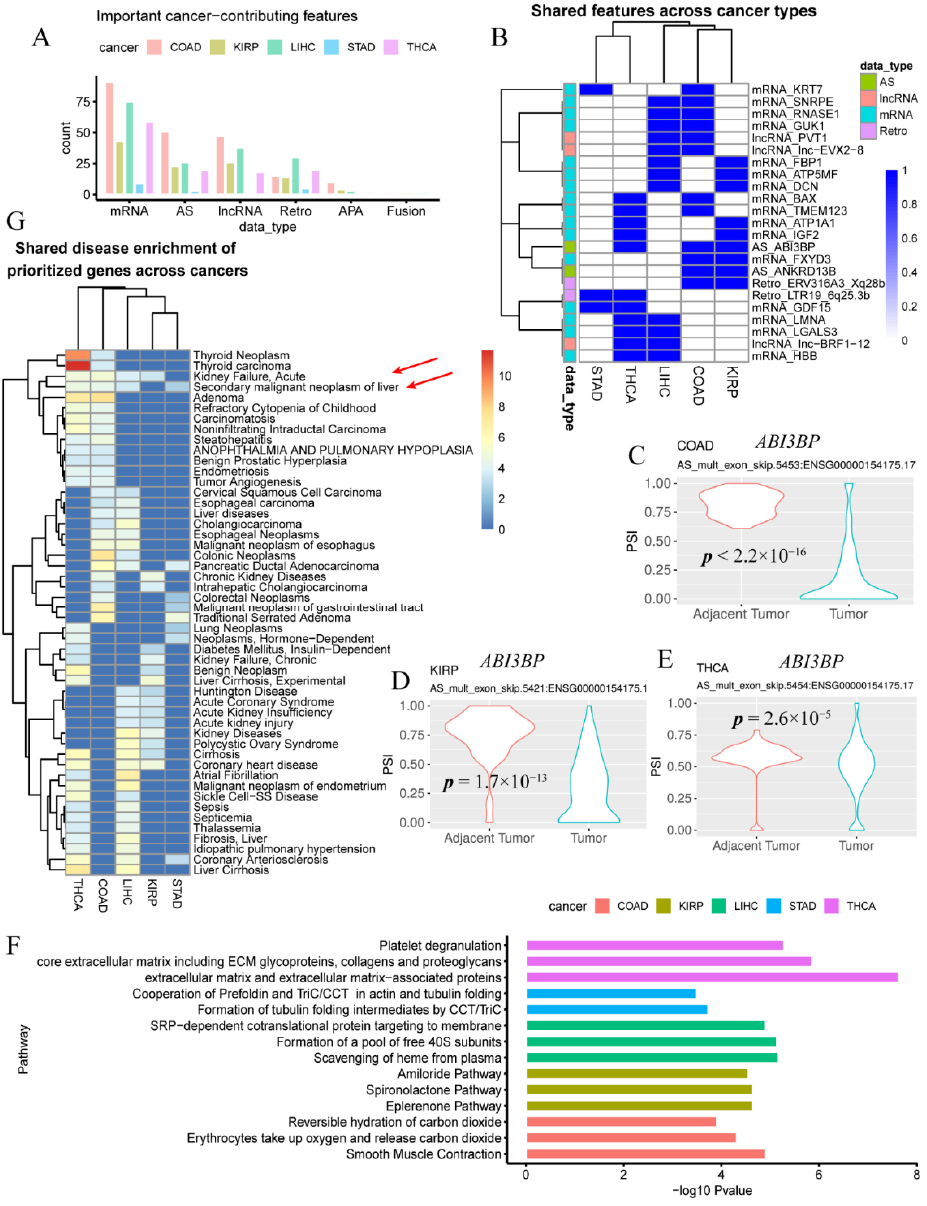
Figure 2. Cancer-associated features and pathways identified by PipeOne in five cancer types. ( A ) Cancer-associated features grouped by feature types across five cancers. ( B ) Cancer-associated features shared by at least two cancer types. ( C – E ) Cancer-associated multi-exon skipping AS event of ABI3BP identified in three cancers, COAD ( C ), KIRP ( D ), and THCA ( E ). ( F ) Top three enriched pathways (only two for STAD) of cancer-associated features in each cancer. ( G ) Shared enriched disease annotations for cancer-associated genes in each cancer. Two annotations shared by